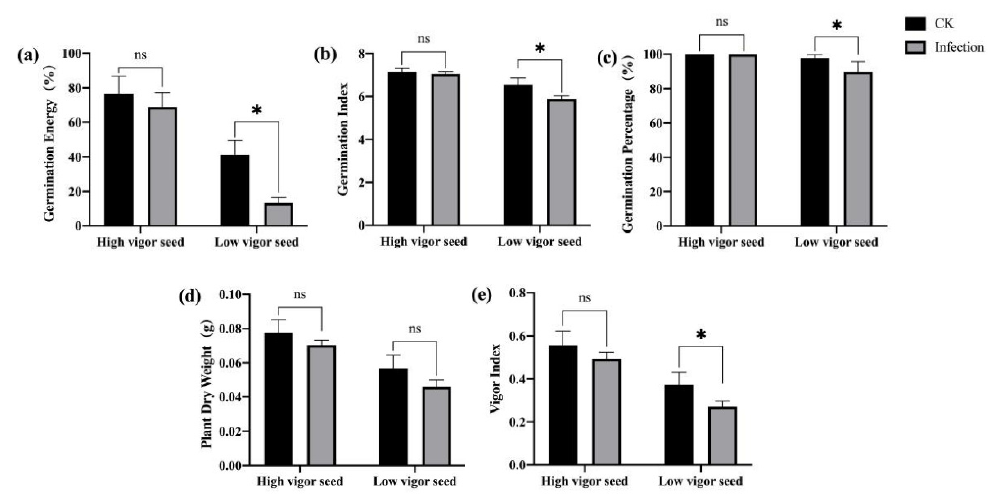
Figure 1. Effects of F. graminearum infection on seed germination and seedling growth of maize with different vigor levels. ( a ) germination energy (%), ( b ) germination index, ( c ) germination percentage (%), ( d ) dry weight of single plant (g), ( e ) vigor index. * indicates p < 0.05 (Student’s t -test), and ns represents not significant.